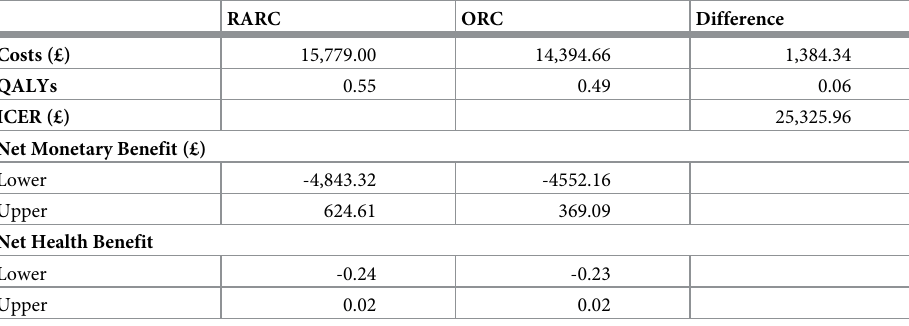
Table 2. Base-case results (written to 2 decimal